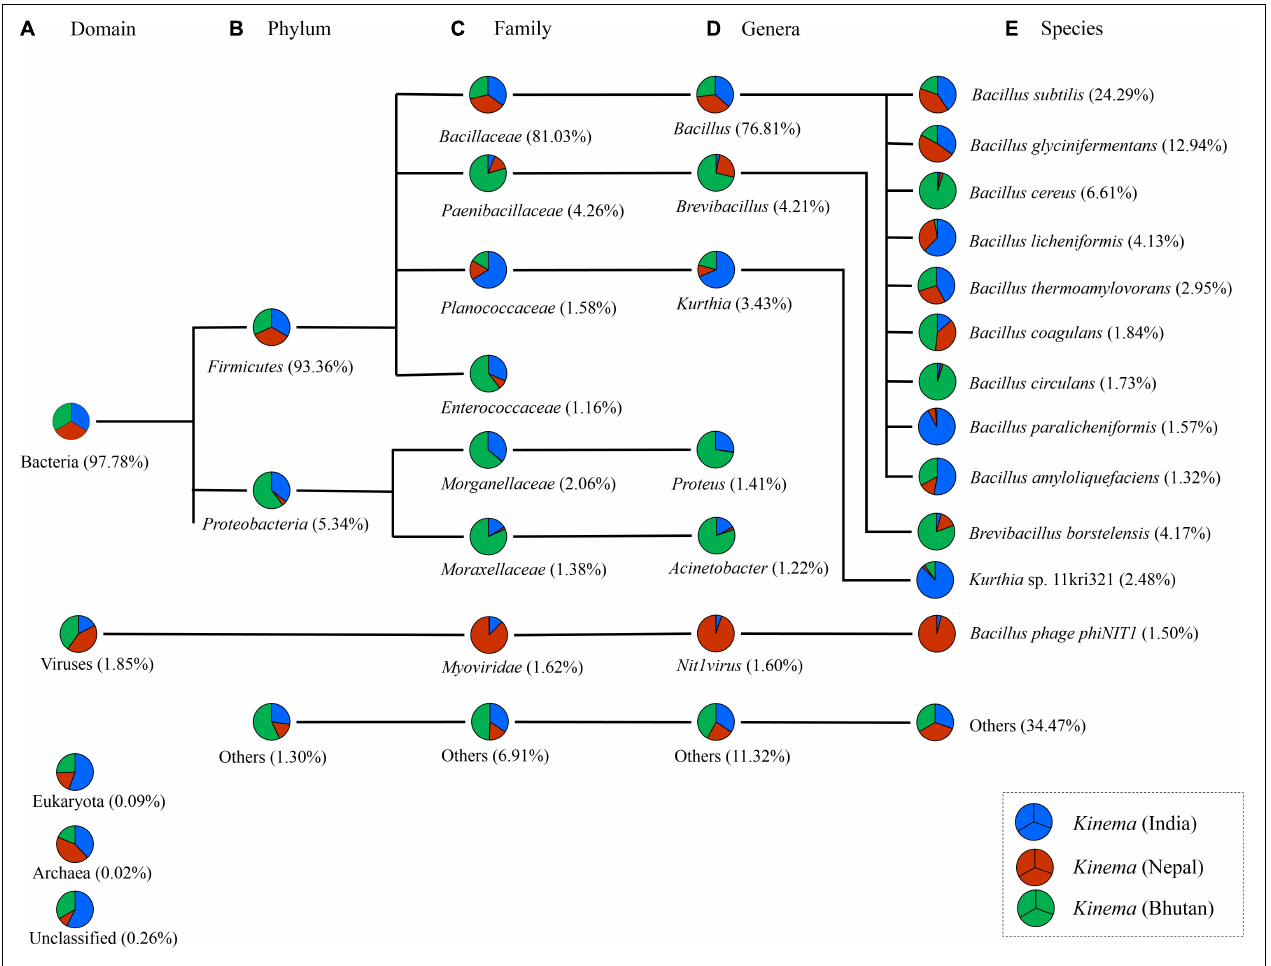
FIGURE 2 | Differences in relative abundance (%) of predominant species in kinema metagenome at different taxonomic levels (A) domain, (B) phylum, (C) family, (D) genus, and (E) species levels. The minor species with a relative percentage of less than 1% were grouped and represented as others.